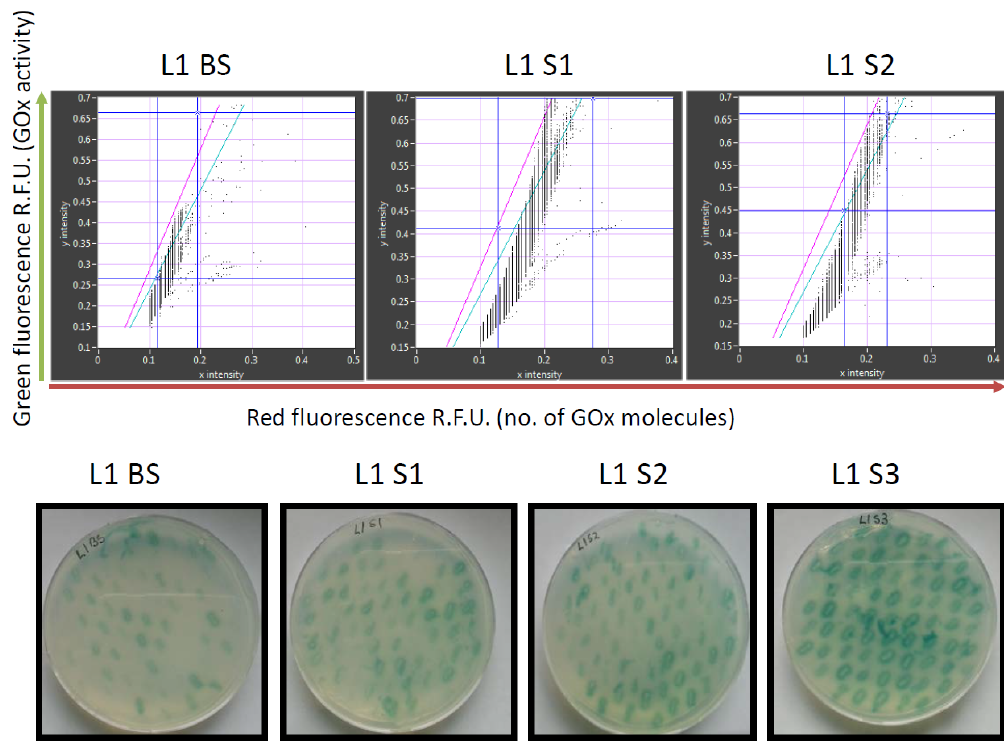
Figure 3. Analysis of glucose oxidase (GOx) library L1 using the new microfluidics system (upper row) and on standard agar plates (lower row). The library was analyzed before sorting ( BS ), after the first ( S1 ), second ( S2 ) and third ( S3 ) rounds of sorting ( S3 ). Red fluorescence (showing the number of GOx molecules) reflects the detection of a C-terminal Myc epitope using a mouse primary anti-c-Myc antibody and a secondary goat anti-mouse IgG antibody labeled with DyLight 550. The sorting gate in the upper panels is between the green and pink lines.